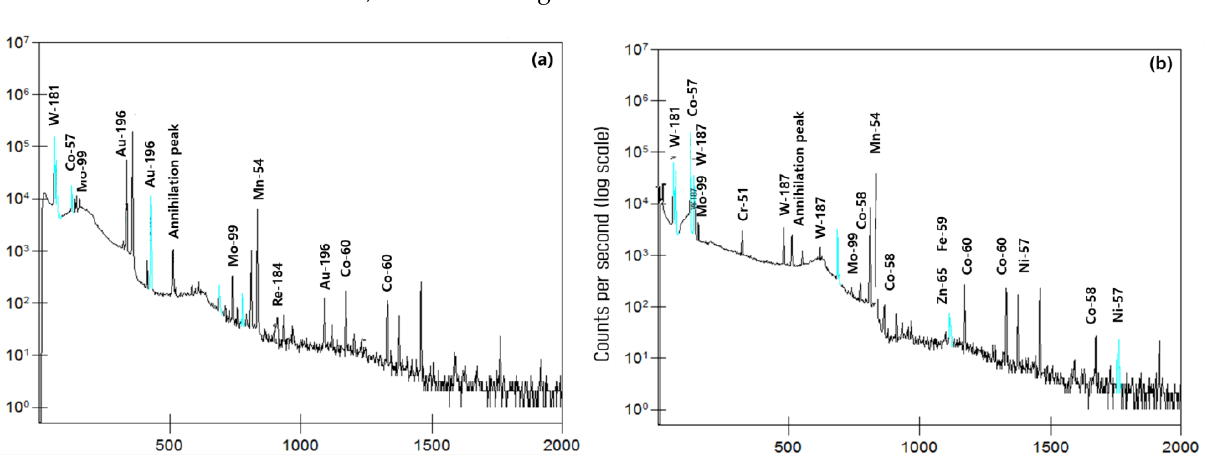
Figure 6. Two examples of the linac component spectrometry with HPGe detector: ( a ) Target, ( b ) 15 MV Primary Collimator. (Blue line: double peak)